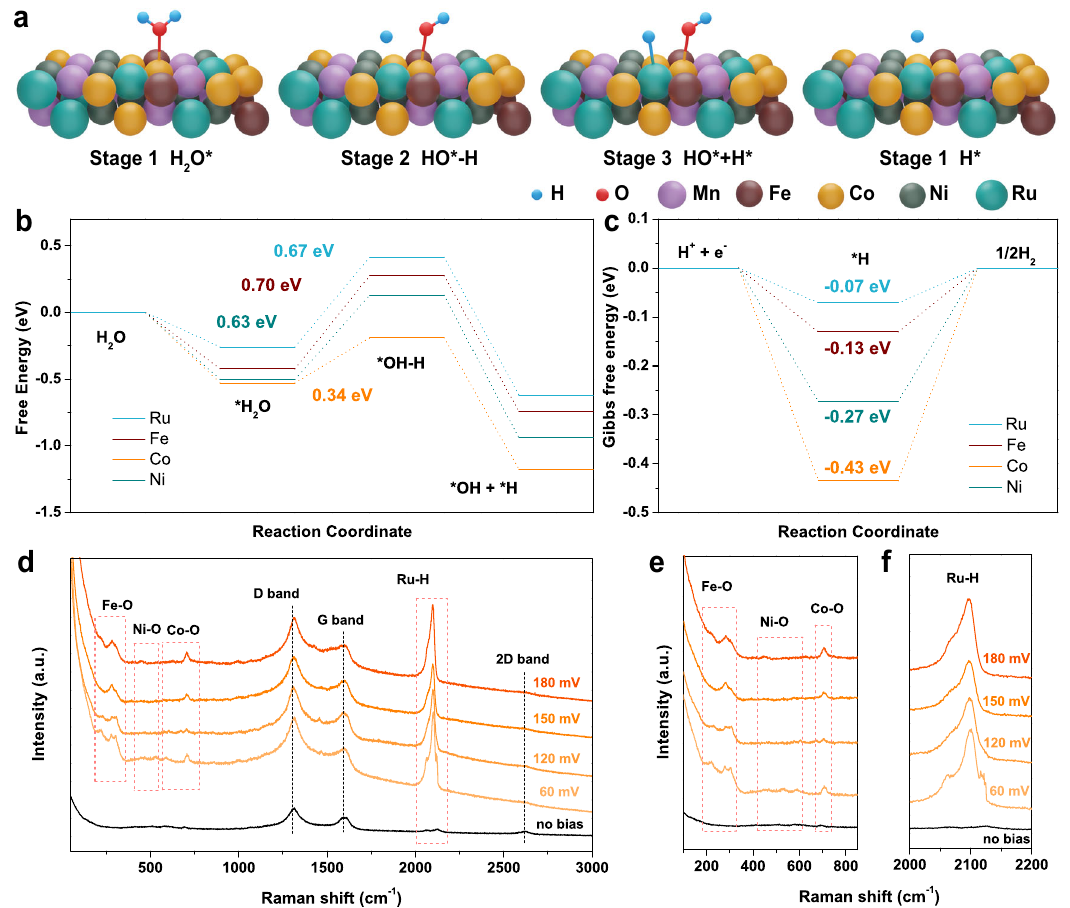
Fig. 6 Theoretical calculation and in situ electrochemical-Raman characterization. a The atomic con fi gurations on catalytic sites of FeCoNiMnRu HEA at the four stages during H 2 O dissociation. b Reaction energy pro fi le for water dissociation on various catalytic sites of the FeCoNiMnRu HEA surface. c Gibbs free energy ( Δ G H* ) pro fi les on various catalytic sites of the FeCoNiMnRu HEA surface. d – f Operando electrochemical-Raman spectra collected for FeCoNiMnRu/CNFs during the HER process in 1.0 M KOH